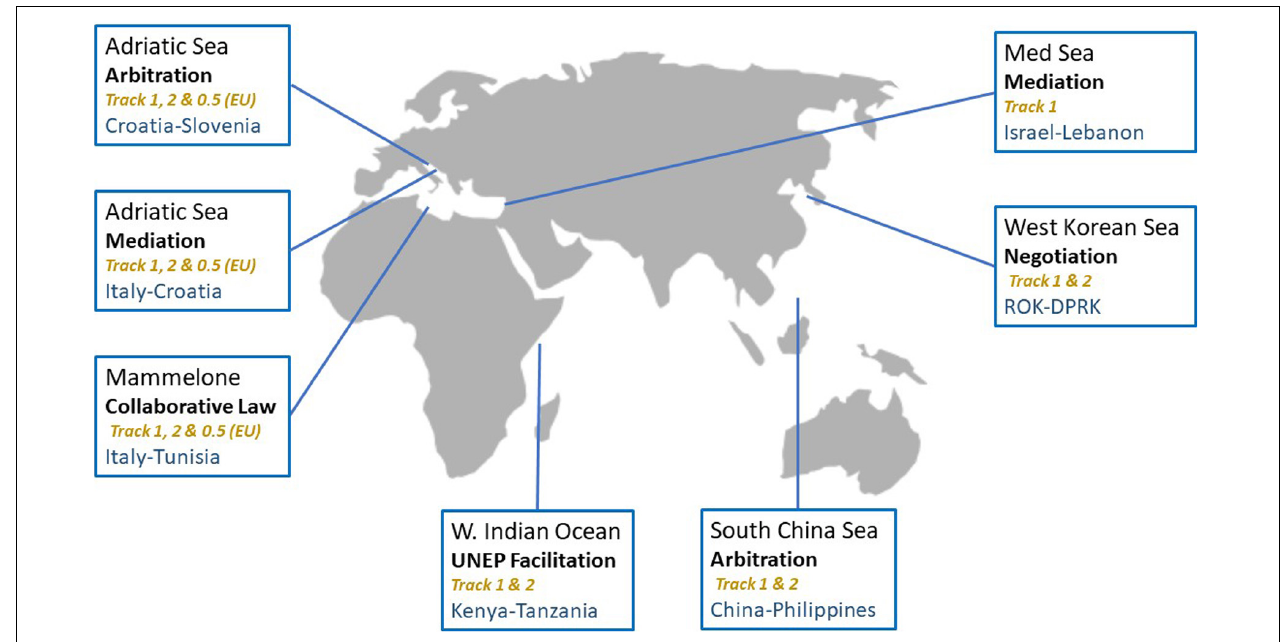
FIGURE 1 | Map of marine-related ADR